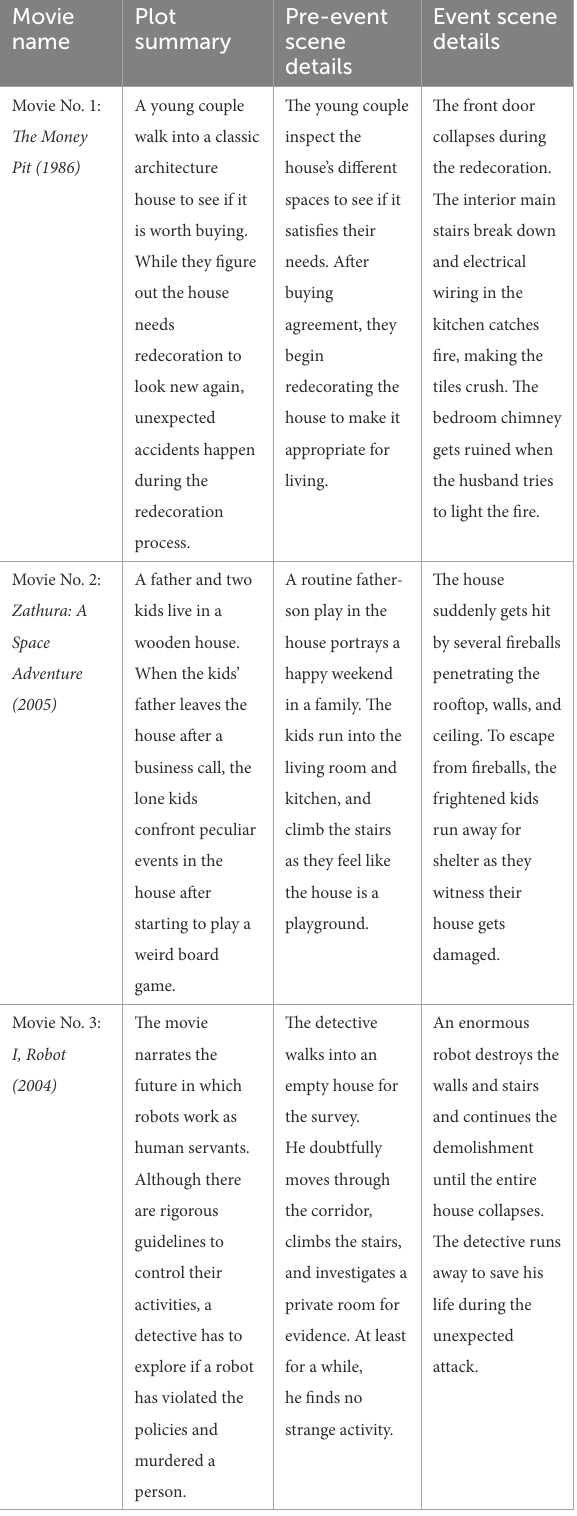
TABLE 1 Films’ plot summaries and space-related